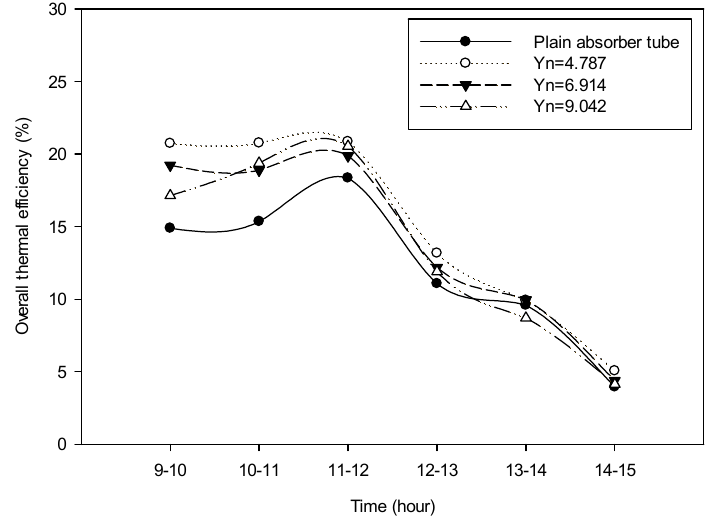
Figure 14. Variation of overall efficiency with time and nail twist pitch ratio.